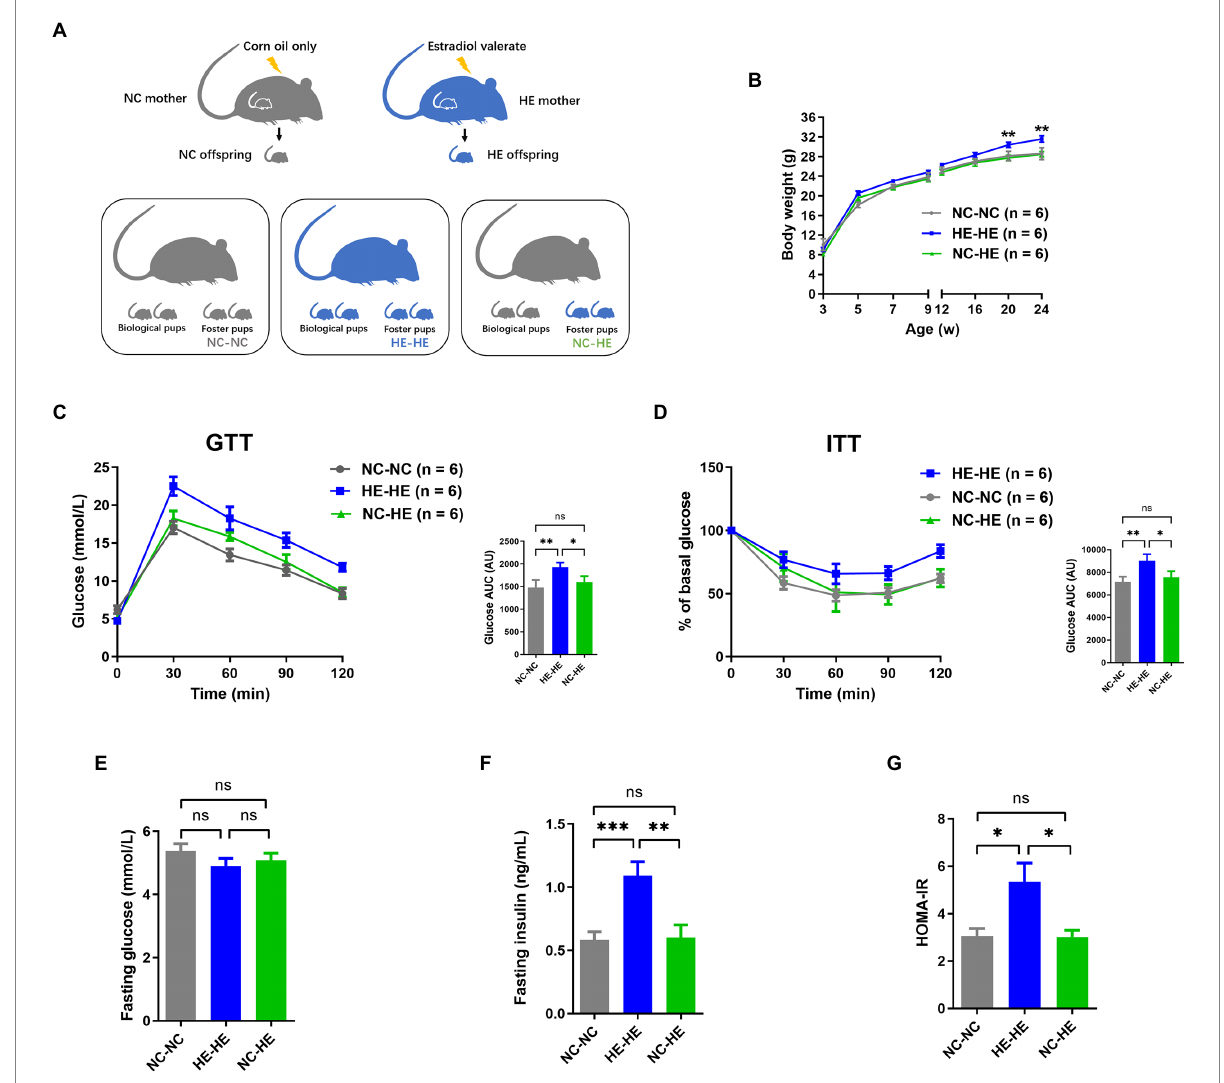
FIGURE 1 Body weight and glucose metabolism assessments of NC-NC, HE-HE, and NC-HE mice from the surrogate fostering mouse model. (A) Schematic of method used to generate the model. (B) Body weight from 3 to 24 weeks after birth. (C) GTT, (D) ITT, (E) fasting glucose, (F) fasting insulin, and (G) HOMA-IR scores at 24 weeks after birth. In (C,D) , left shows raw data and right shows AUC in arbitrary units (AU). Error bars represent SEM. Significance determined by one-way ANOVA. * p < 0.05; ** p < 0.01; *** p < 0.001; ns, not